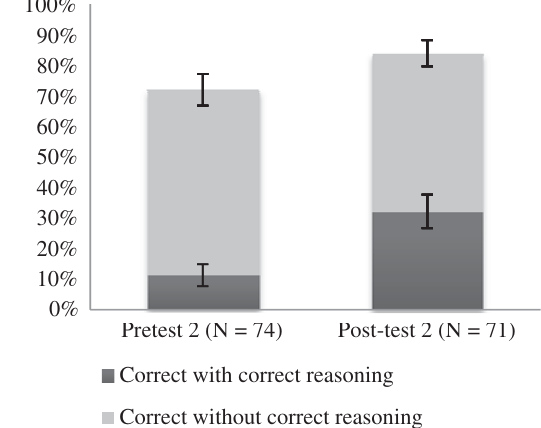
FIG. 5. Student performance on question 2, before and after completion of the tutorials. Error bars represent the standard